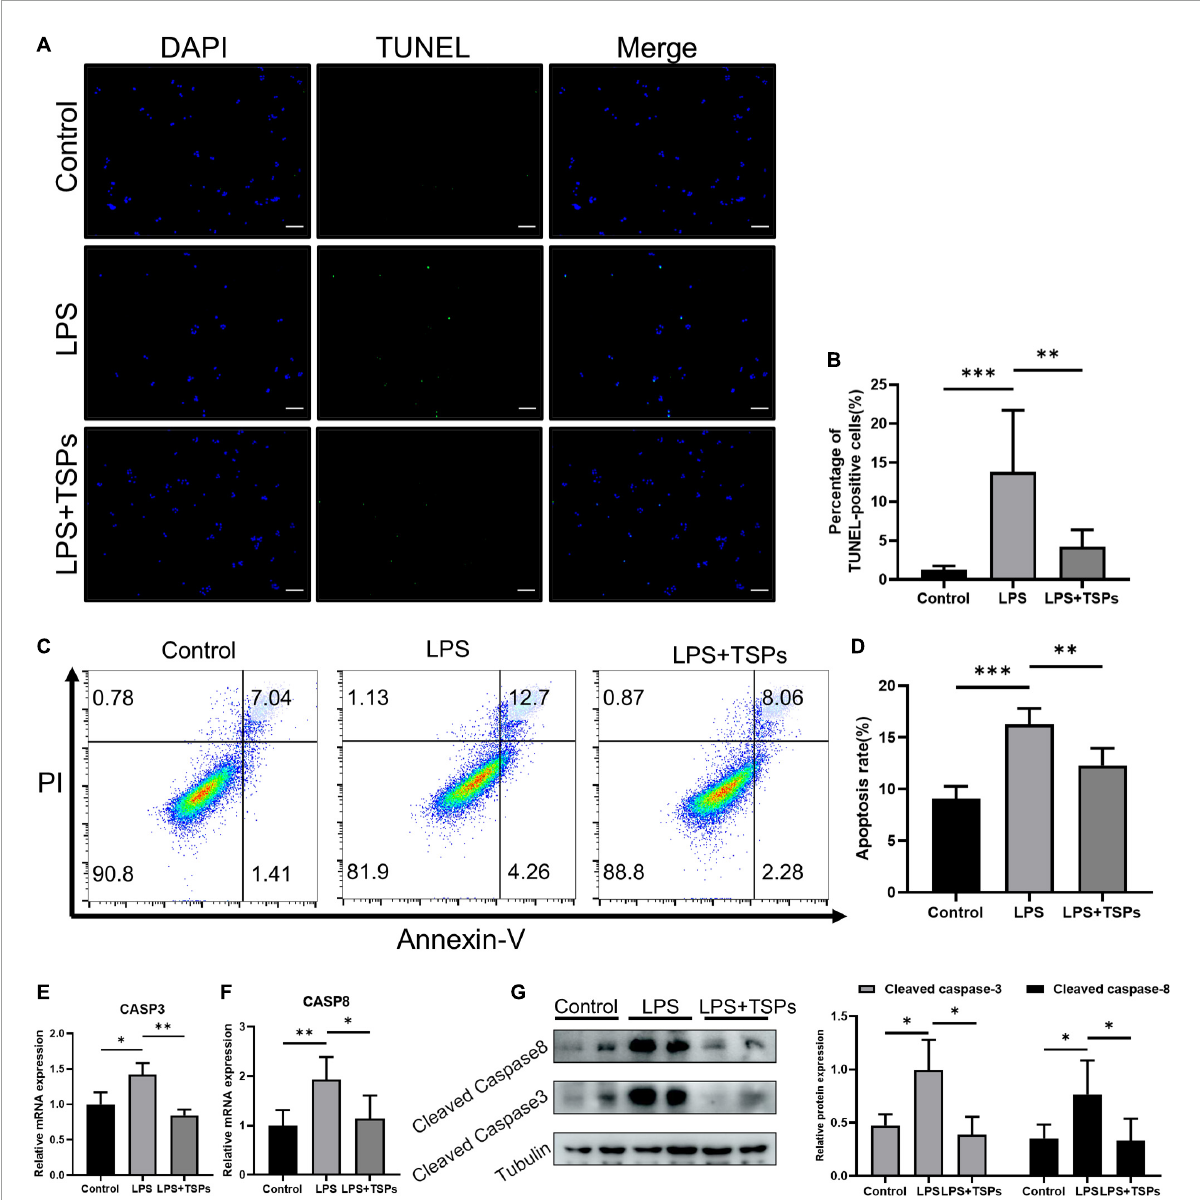
FIGURE4 TSPs prevented LPS-Induced Apoptosis in HT-29. (A) Representative images of TUNEL staining in HT-29 cells. Scale bar = 100 µ m. (B) Quantification of the percentage of TUNEL positive cells ( n = 6). (C) Apoptosis analysis of HT-29 cells by flow cytometry. (D) The results of quantitative analyses of apoptosis rate ( n = 5). (E,F) Caspase-3 and caspase-8 levels were measured by qRT-PCR ( n ≥ 3). (G) Western blot analysis of the cleaved caspase-3 and cleaved caspase-8 proteins in HT-29 cells and semi-quantitative analysis of relative indicated proteins expression ( n = 5). Data were presented as means ± SD. Statistical significance was determined using one-way ANOVA. ∗ P < 0.05, ∗∗ P < 0.01, ∗∗∗ P <